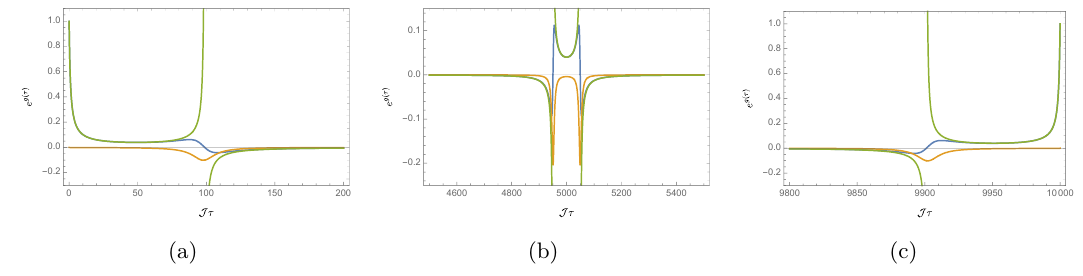
Figure 6 . The two-point function as a function of time for β J = 10 5 . The green curve corresponds to s 2 = − 0 . 01 , while the blue and yellow curves are the real and imaginary parts when s 2 = − 0 . 01 + 0 . 001 i . We only show the times close to the divergences for the negative coupling and see that the complex coupling gives a smooth two-point function instead.